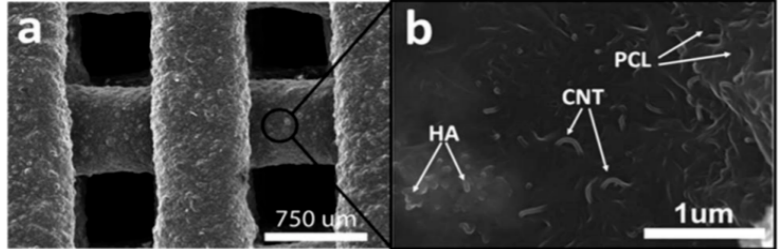
Figure 13. ( a ) SEM images of PCL/Hydroxyapatite (HA)/multiwalled carbon nanotube (MWCNT) scaffold fabricated using DIW. ( b ) Images with higher magnification. MWCNTs that were incorporated at a low level of loading were well-dispersed within the polymer matrix, which increased the mechanical properties (reprinted from [274], with permission from